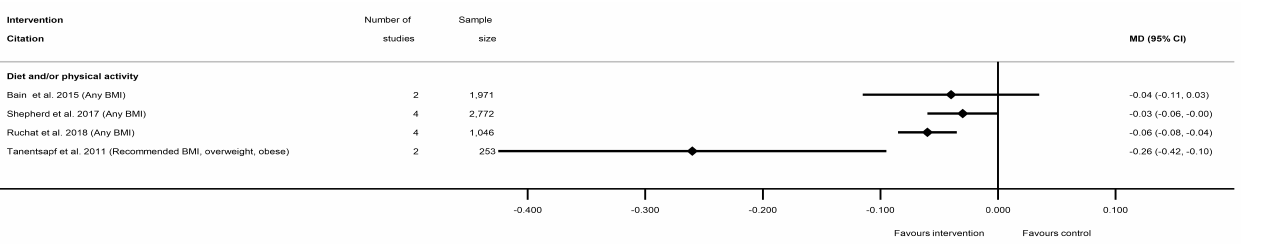
Figure 3. Forest plot of meta-analysis results for weekly gestational weight gain